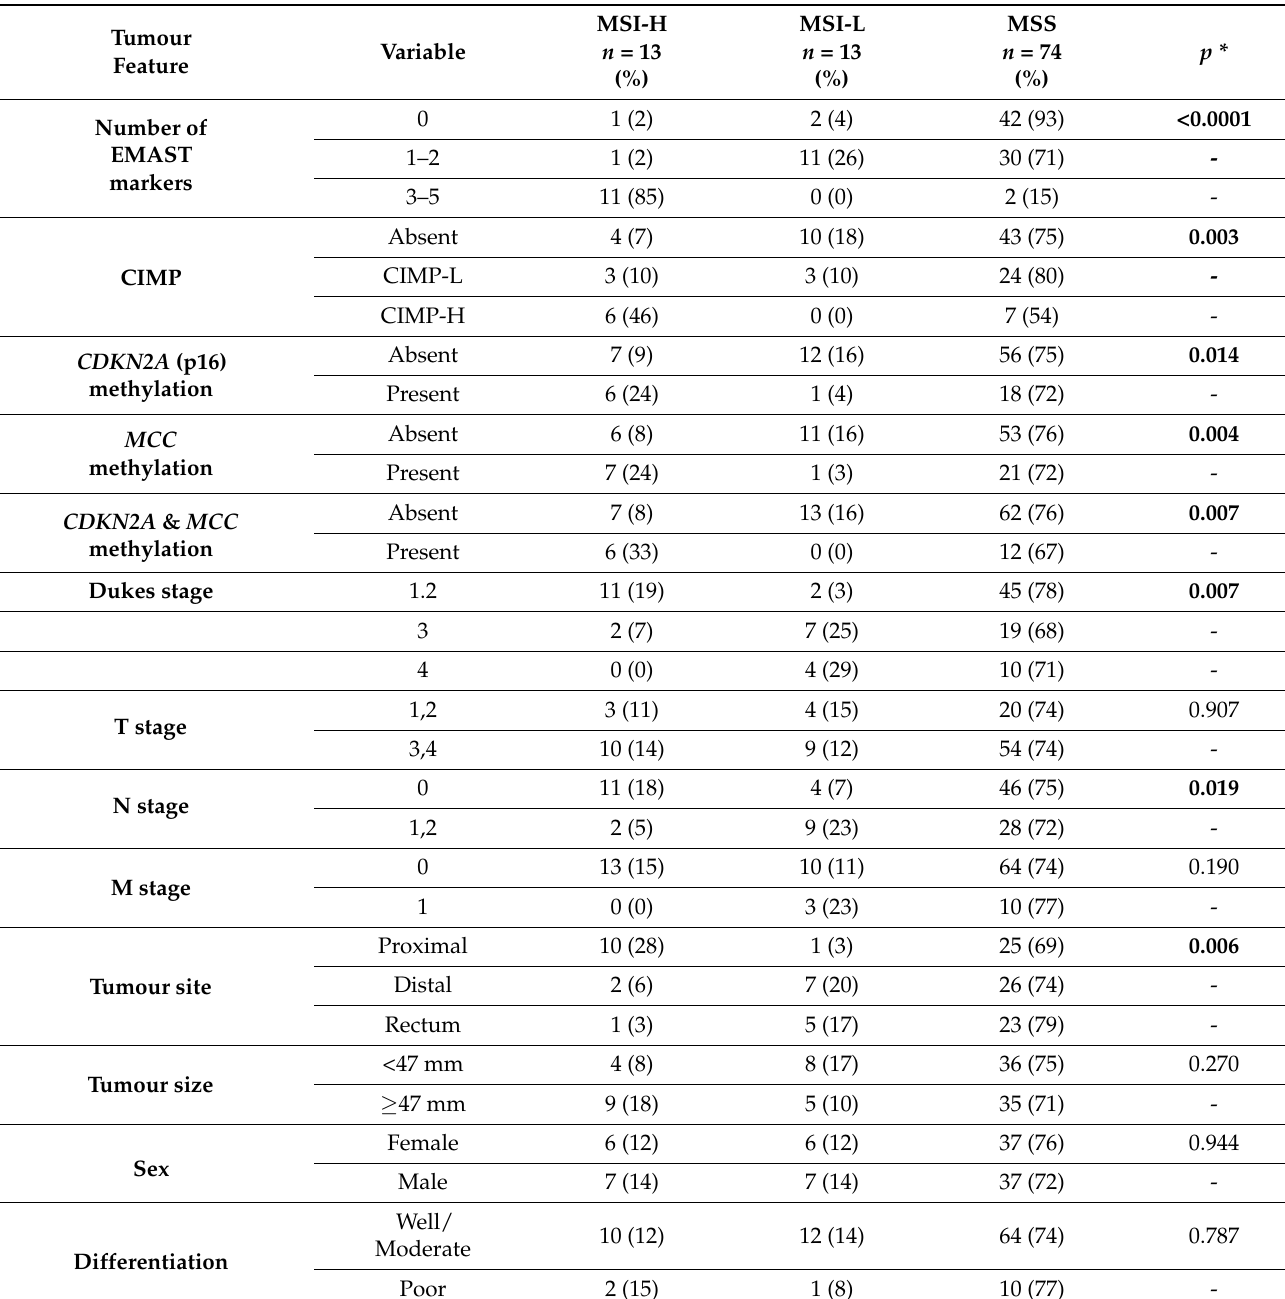
Table 2. Association of MSI-H and MSI-L with clinicopathological features and molecular markers in sporadic colorectal cancer (cohort